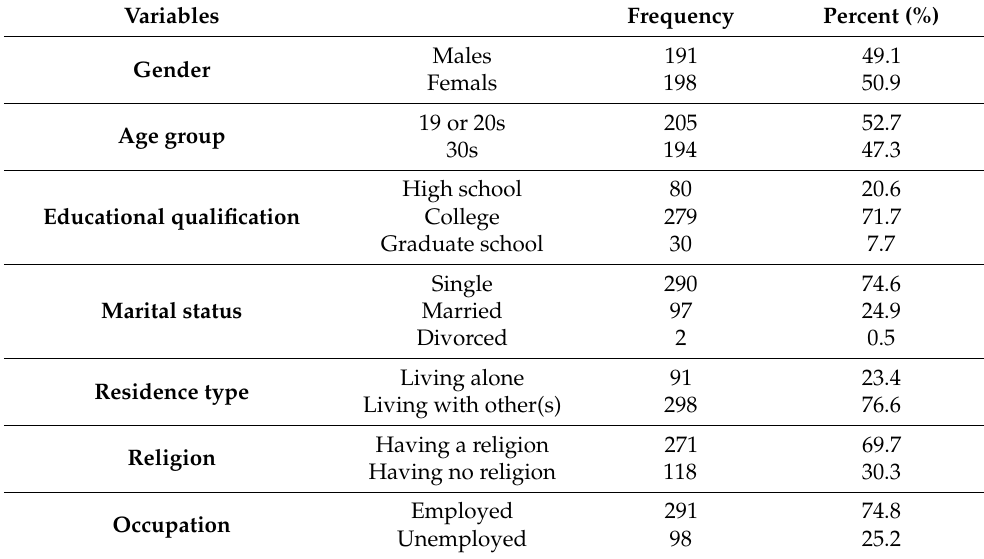
Table 1. Participants’ characteristics ( N =